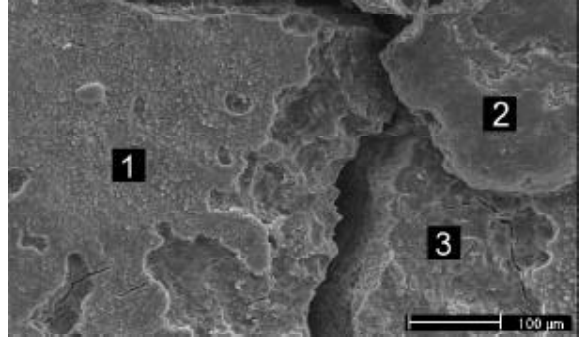
FIGURA 4- grupo 2 – dentes contaminados: 1. cemento aparentemente normal; 2. massa de cálculo, 3. reabsorção cementária (aumento 200X)